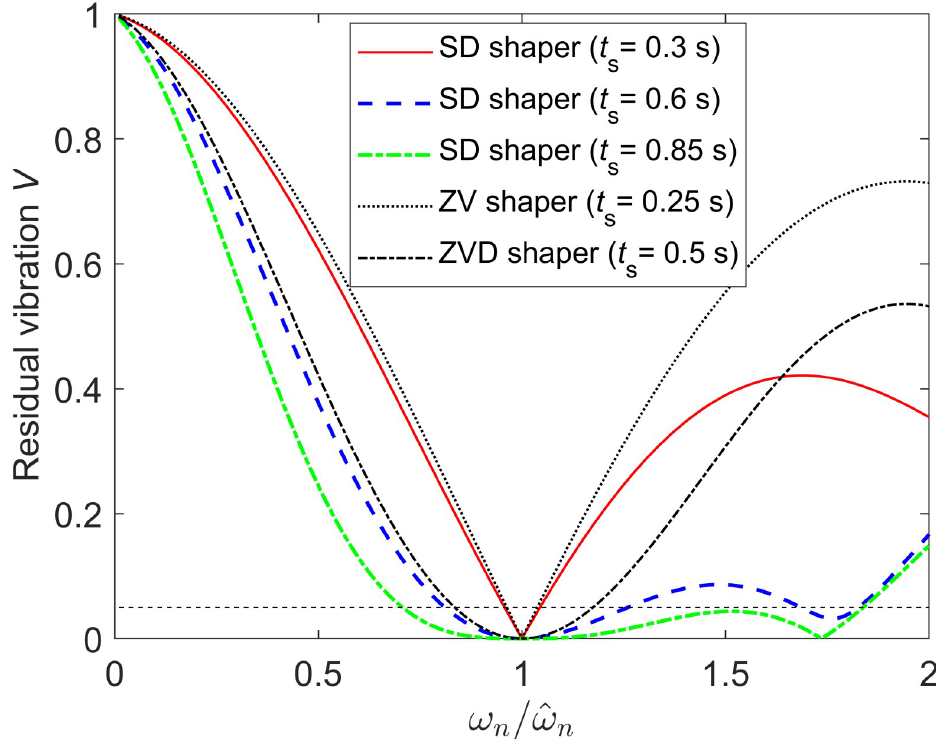
Fig 6. Sensitivity curves of the SD shapers with shaping time t = ð s 2 þ 2 ζω Þ with ^ ω ¼ 2 Hz and ζ = 0.1. Because the dimensionless shaping times are 0.597, 1.194, and ω 2 s þ ω 2 n n n n 1.692, SD shapers are composed of three, four, and five impulses, respectively, and 5% insensitivities I 0.05 are 0.088, 0.452, and 1.133,